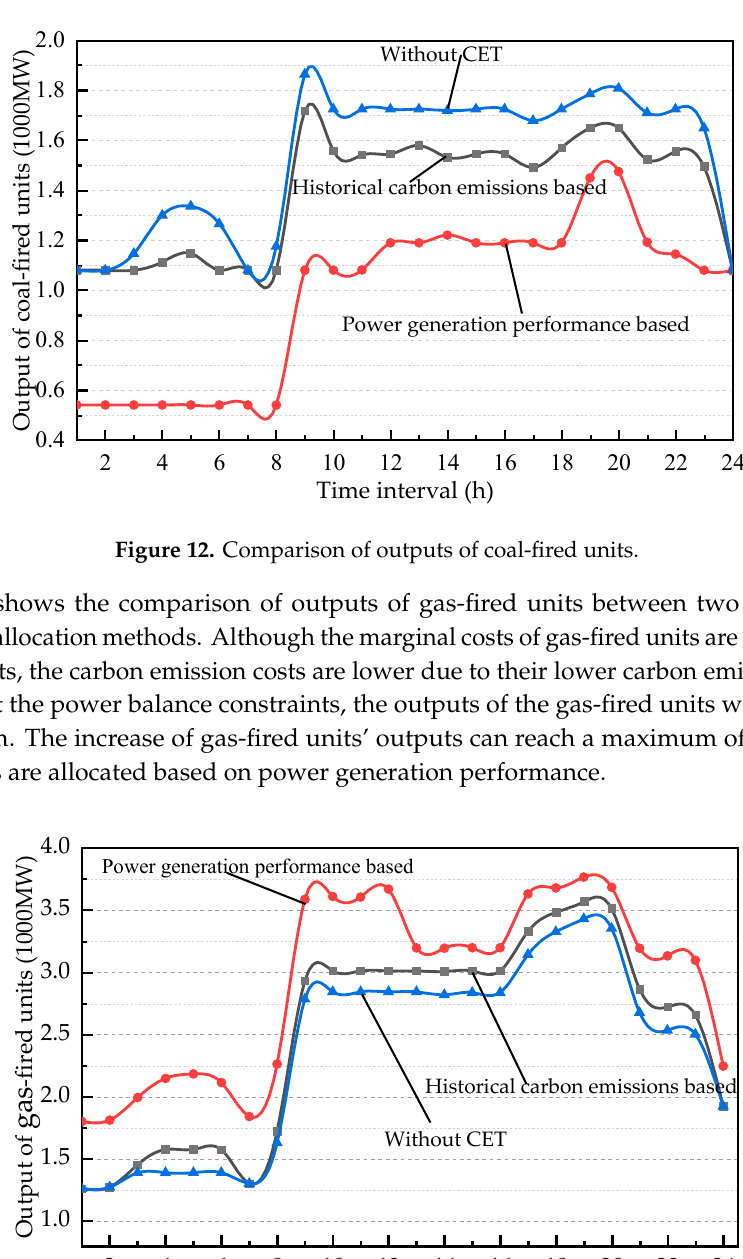
Figure 11. Comparison of carbon emissions of conventional units.